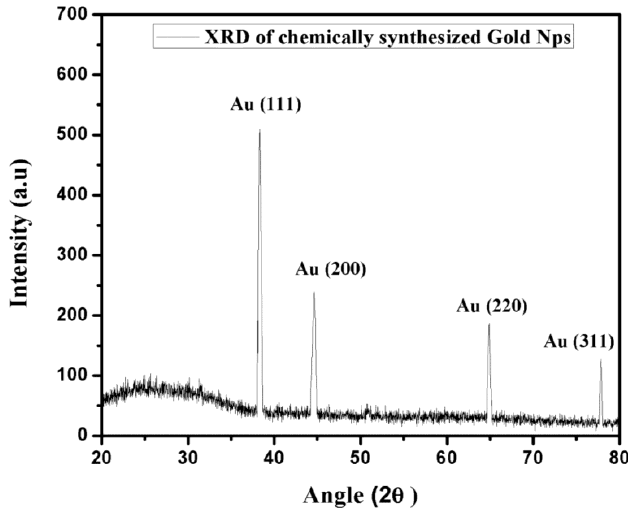
Figure 3. X-ray diffraction pattern of chemically synthesized gold nanoparticles.